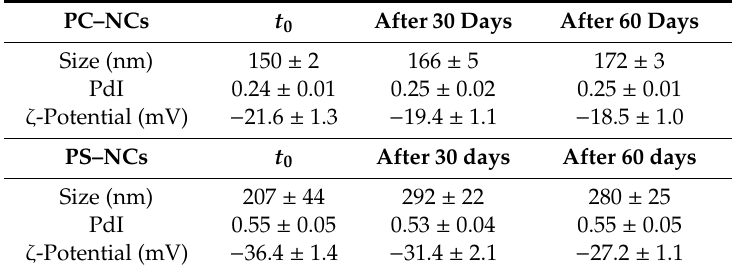
Table 2. The particle size, polydispersity index (PdI) and ζ -potential of PC–NCs and PS–NCs as a lyophilised product after two-month storage at 25 ◦ C.